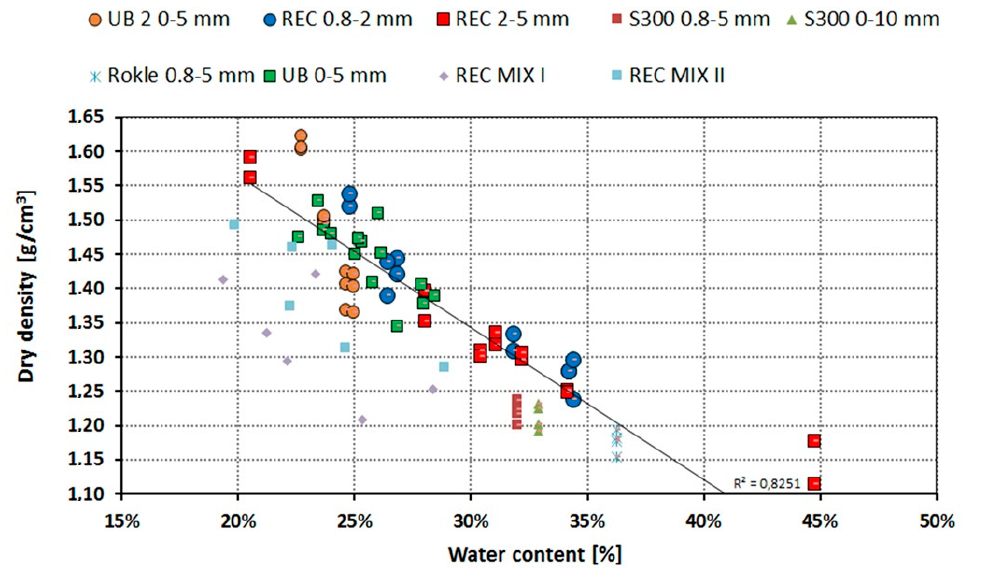
Figure 9. Results of the testing of the sprayed bentonite layer from this testing and comparison with data from previous